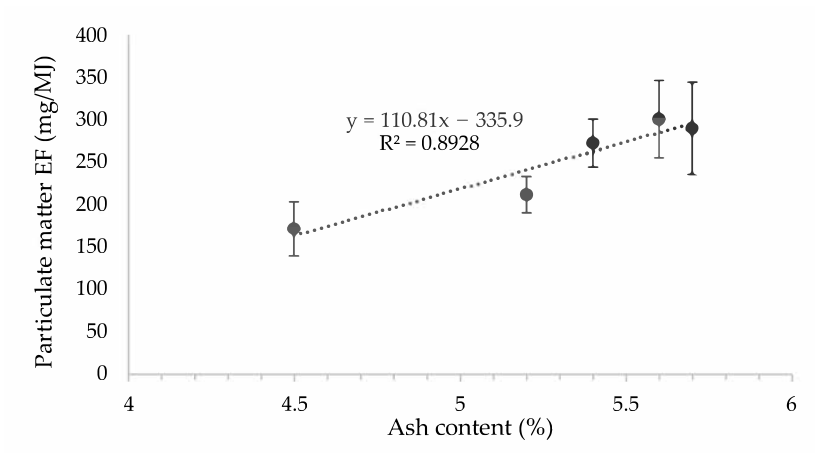
Figure 4. Relation between the particulate matter emission factor and the pellet ash